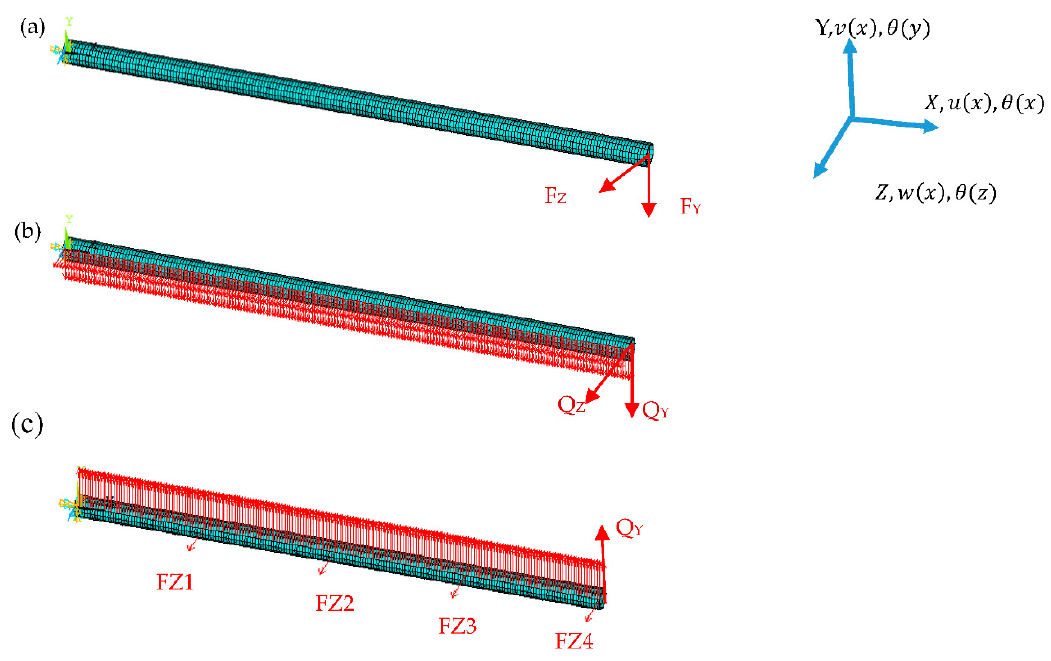
Figure 7. Loading cases on cantilever beam: ( a ) end-node forces: FY = − 100 N, FZ = 80 N; ( b ) uniform distribution loads: Q Z = 1.5 N, Q Y = − 1 N; ( c ) complex loads: uniform loads (Q Y = 1 N) in direction Y and four equal node forces in direction Z (FZ1 = FZ2 = FZ3 = FZ4 = 150 N).